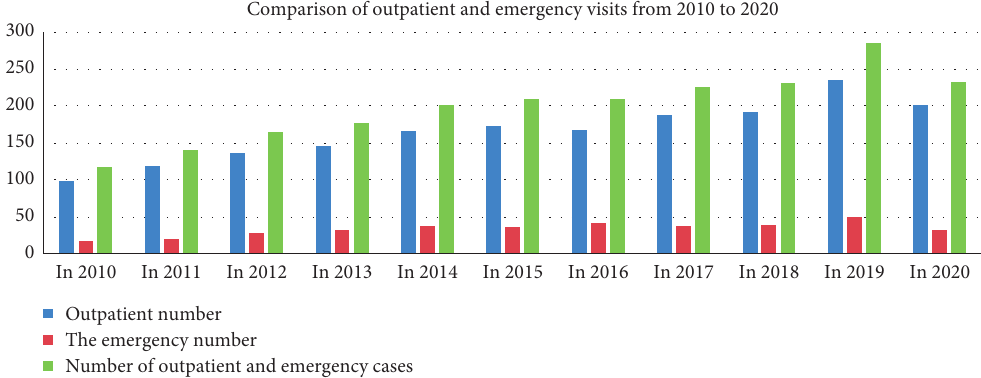
Figure 1: Comparison of total outpatient and emergency volume and outpatient volume from 2010 to 2020 (West China Second Hospital of Sichuan University).